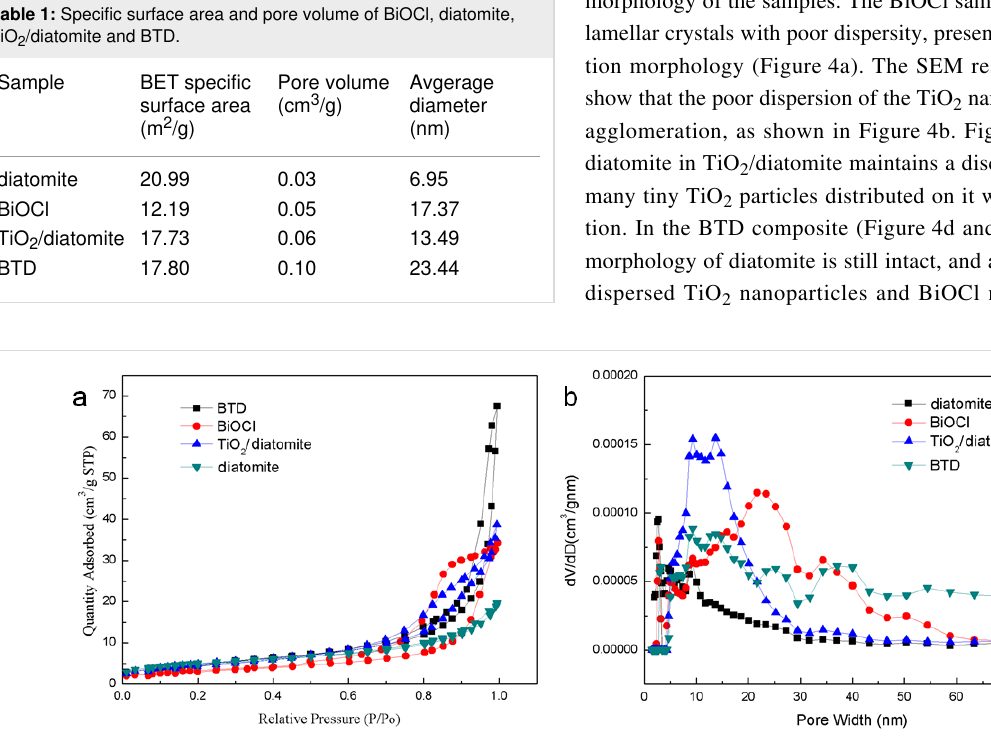
Figure 2: N 2 adsorption–desorption isotherms (a) and pore size distribution plots (b) of the samples.